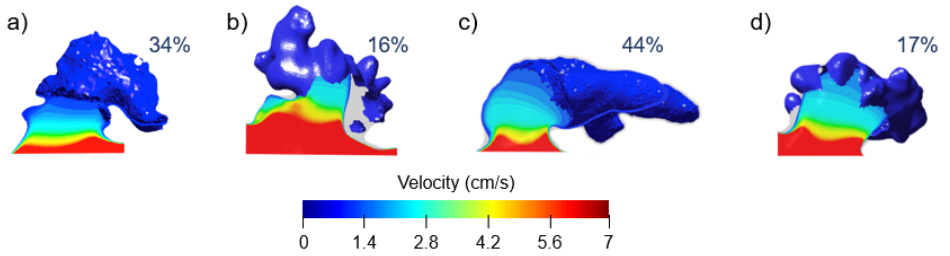
Figure 8. Velocity field for a specific plane with overlapped volume cells presenting a velocity value below 0.001 cm/s for CW ( a ), CF ( b ), WS ( c ) and CS shape ( d ).